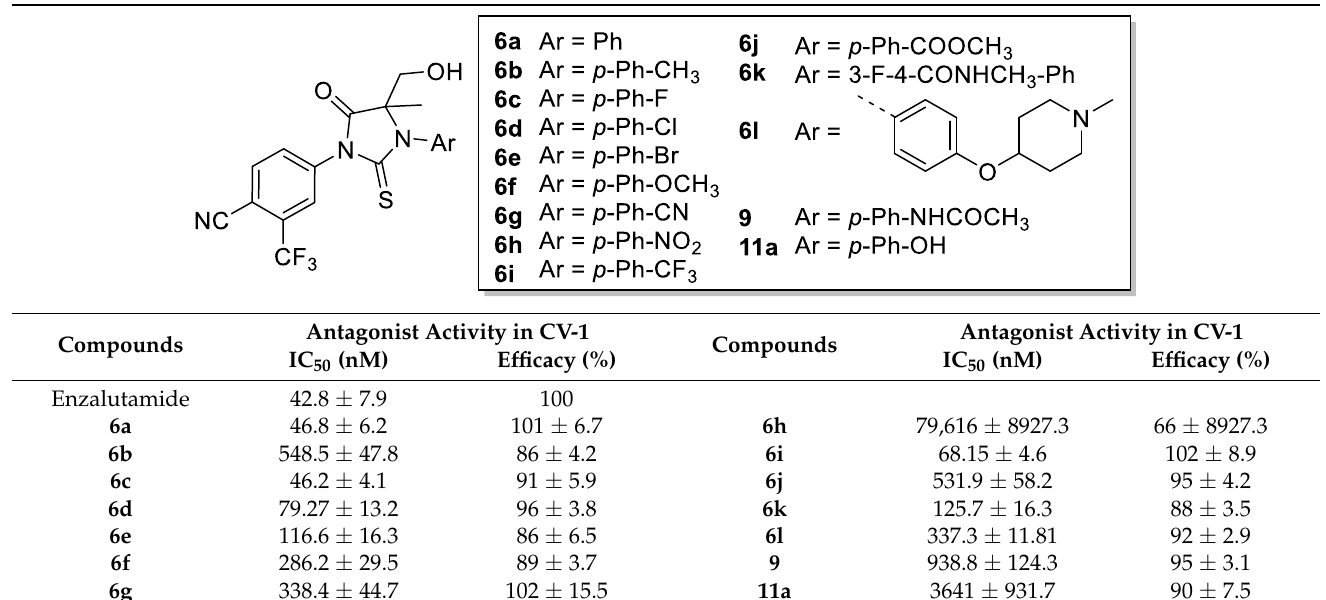
Table 1. Bioactivity of compounds 6a-l , 9 and 11a .